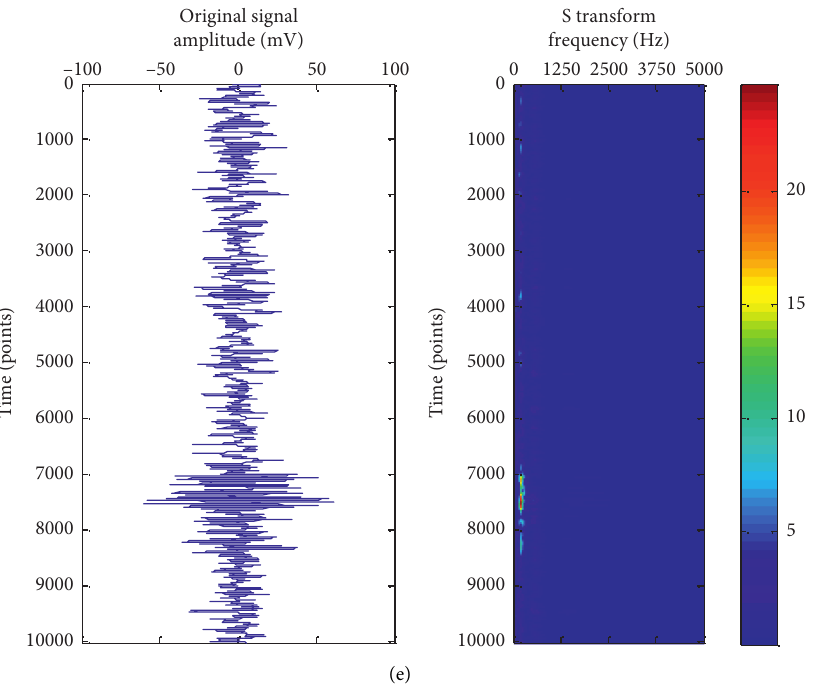
Figure 6: Comparison of S-transform results of different microseismic events. (a) S-transform cloud map of rock. (b) S-transform cloud map of rock. (c) S-transform cloud map of coal fracture caving. (d) S-transform cloud map of coal caving. (e) S-transform cloud map of noise